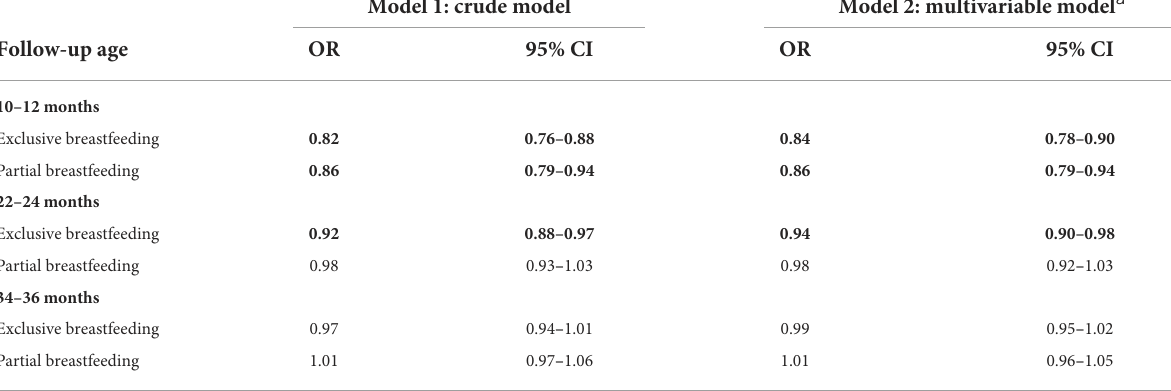
TABLE 3 Analysis of the cumulative risk for breastfeeding and KD according to follow-up months. Model 1: crude